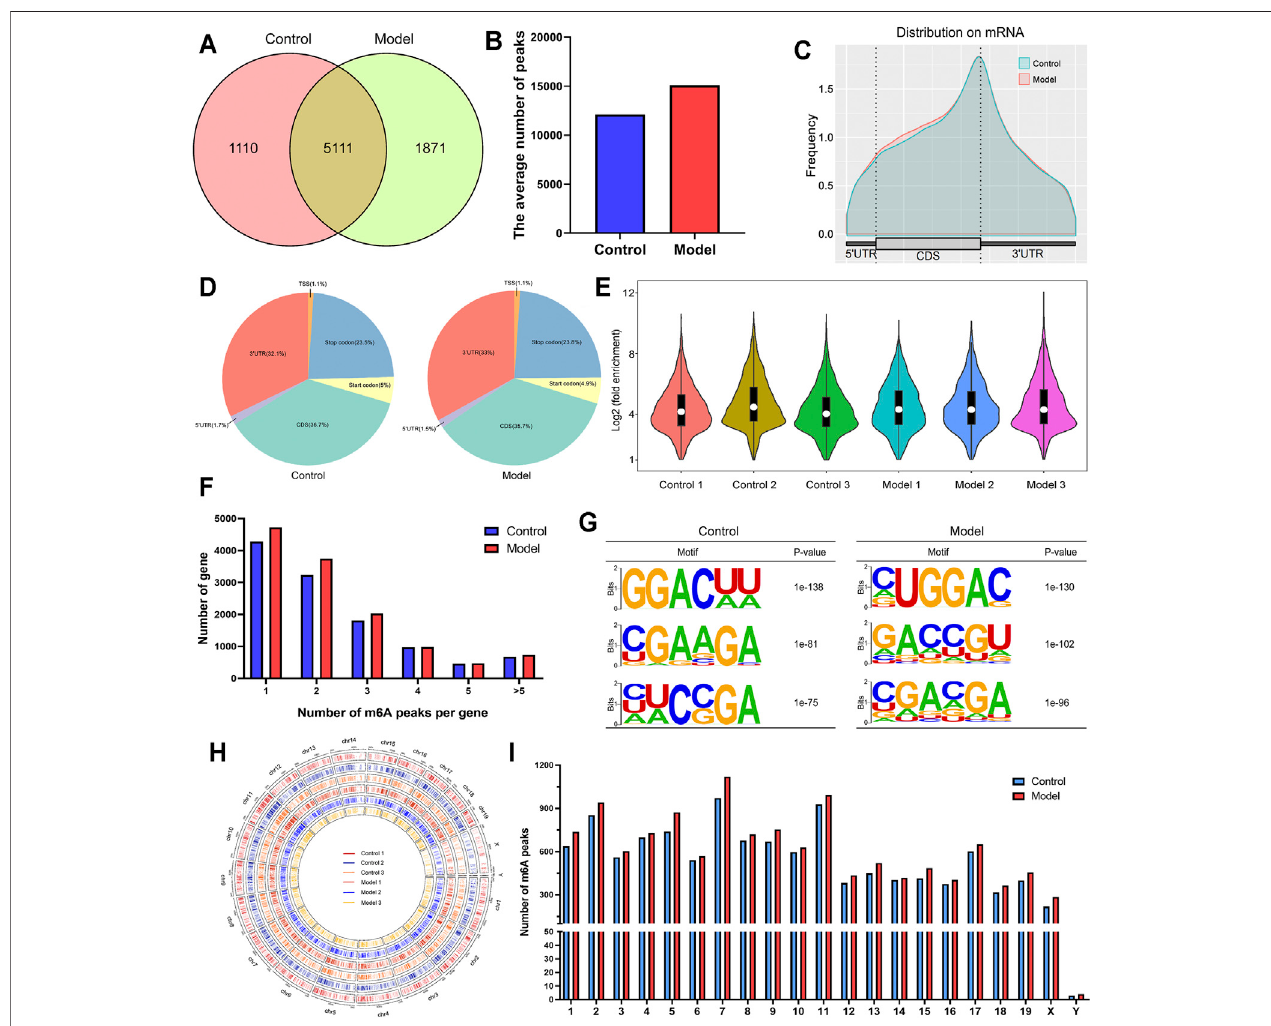
FIGURE3| Overviewofm6A-modi fi edtranscriptsinLFmice. (A) Venndiagramofm6A-modi fi edgenesinthecontrolgroupandthemodelgroup. (B) Theaverage number of m6A peaks in each group. (C) Density of differential m6A peaks along transcripts. Each transcript was divided into three parts: 5 ′ UTR, CDS, and 3 ′ UTR. (D) Pie charts showing the region of m6Apeaks in each group. (E) Violin plot ofthe relative abundance ofm6A peaks in each group. (F) Number of peaks per transcript. (G) Themostconservedsequencemotifofthedifferentialm6Apeakregion. (H) Thedistributionpatternsofm6Apeaksindifferentchromosomes. (I) Thecountofm6A peaks in per